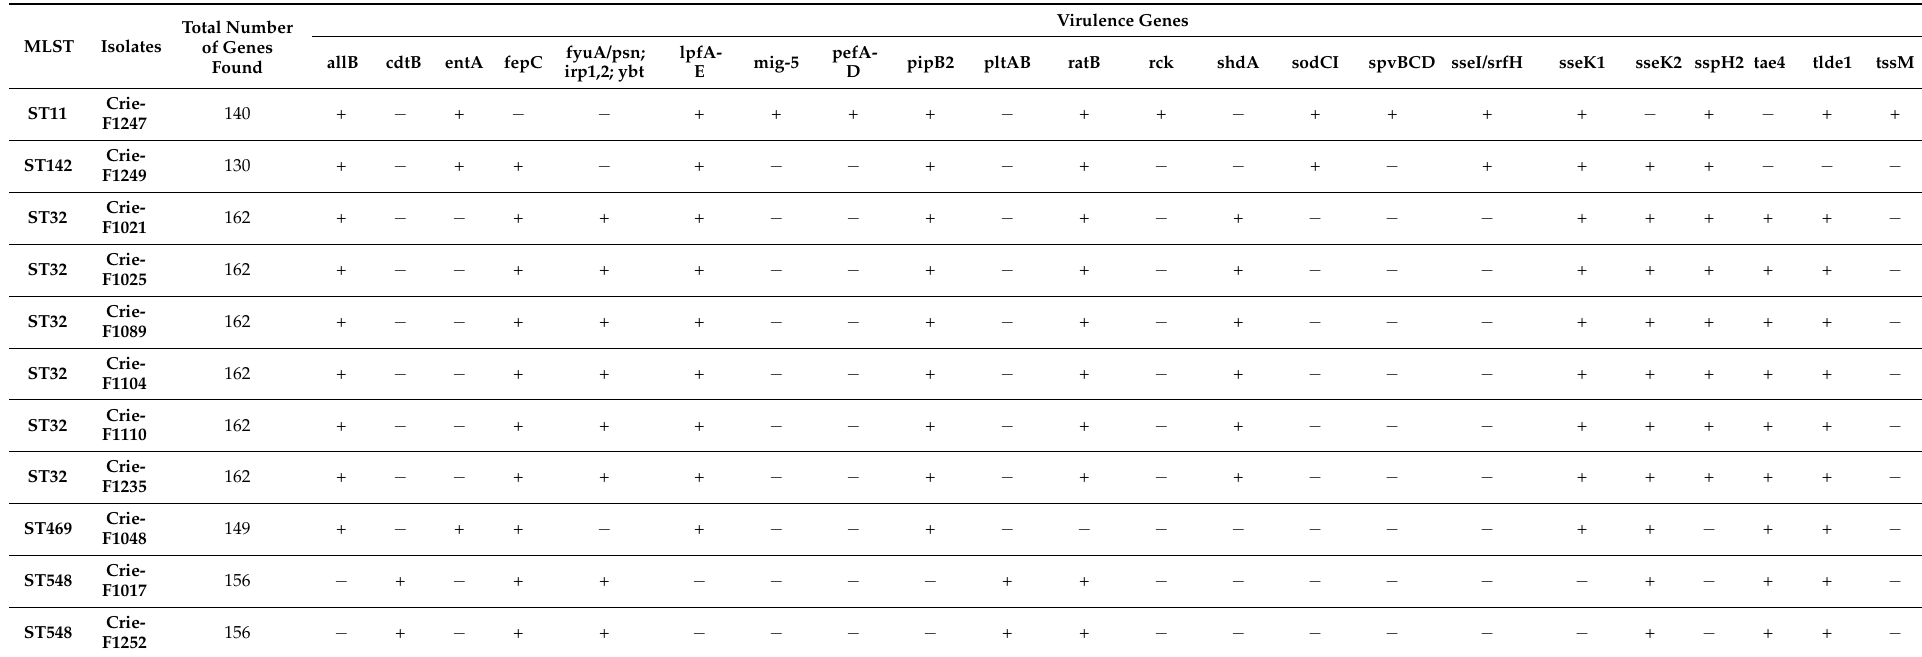
Table 1. Virulence profiles of foodborne S. enterica isolates